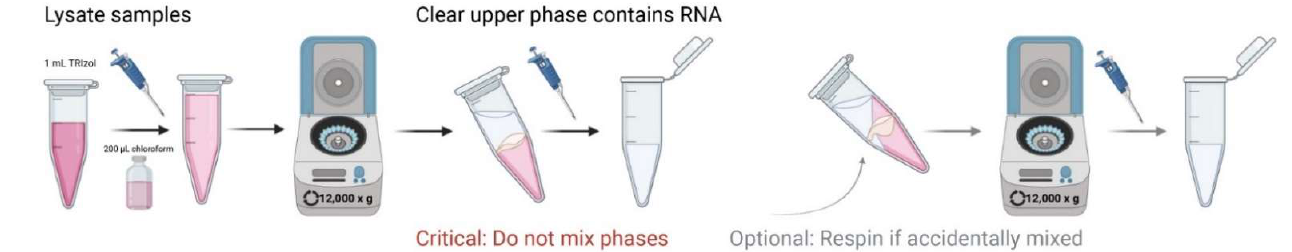
Figure 5. Schematic workflow of critical step in isolation of clear upper phase during phenol- chloroform (TRIzol) RNA extraction of isolated microglia and astrocytes.